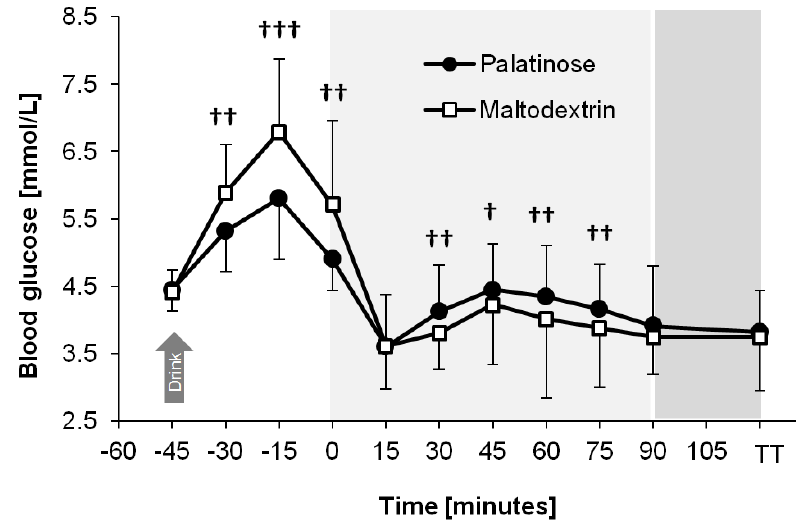
Figure 3. Plasma glucose profiles during the PSE and MDX trials, presented as mean ± SD ( N = 20). The symbols † , †† , and ††† denote a possible, likely, and very likely difference between the PSE and MDX trials at the corresponding time point, respectively. From 0 min to 90 min: endurance exercise. TT = blood sample drawn upon completion of the time trial.